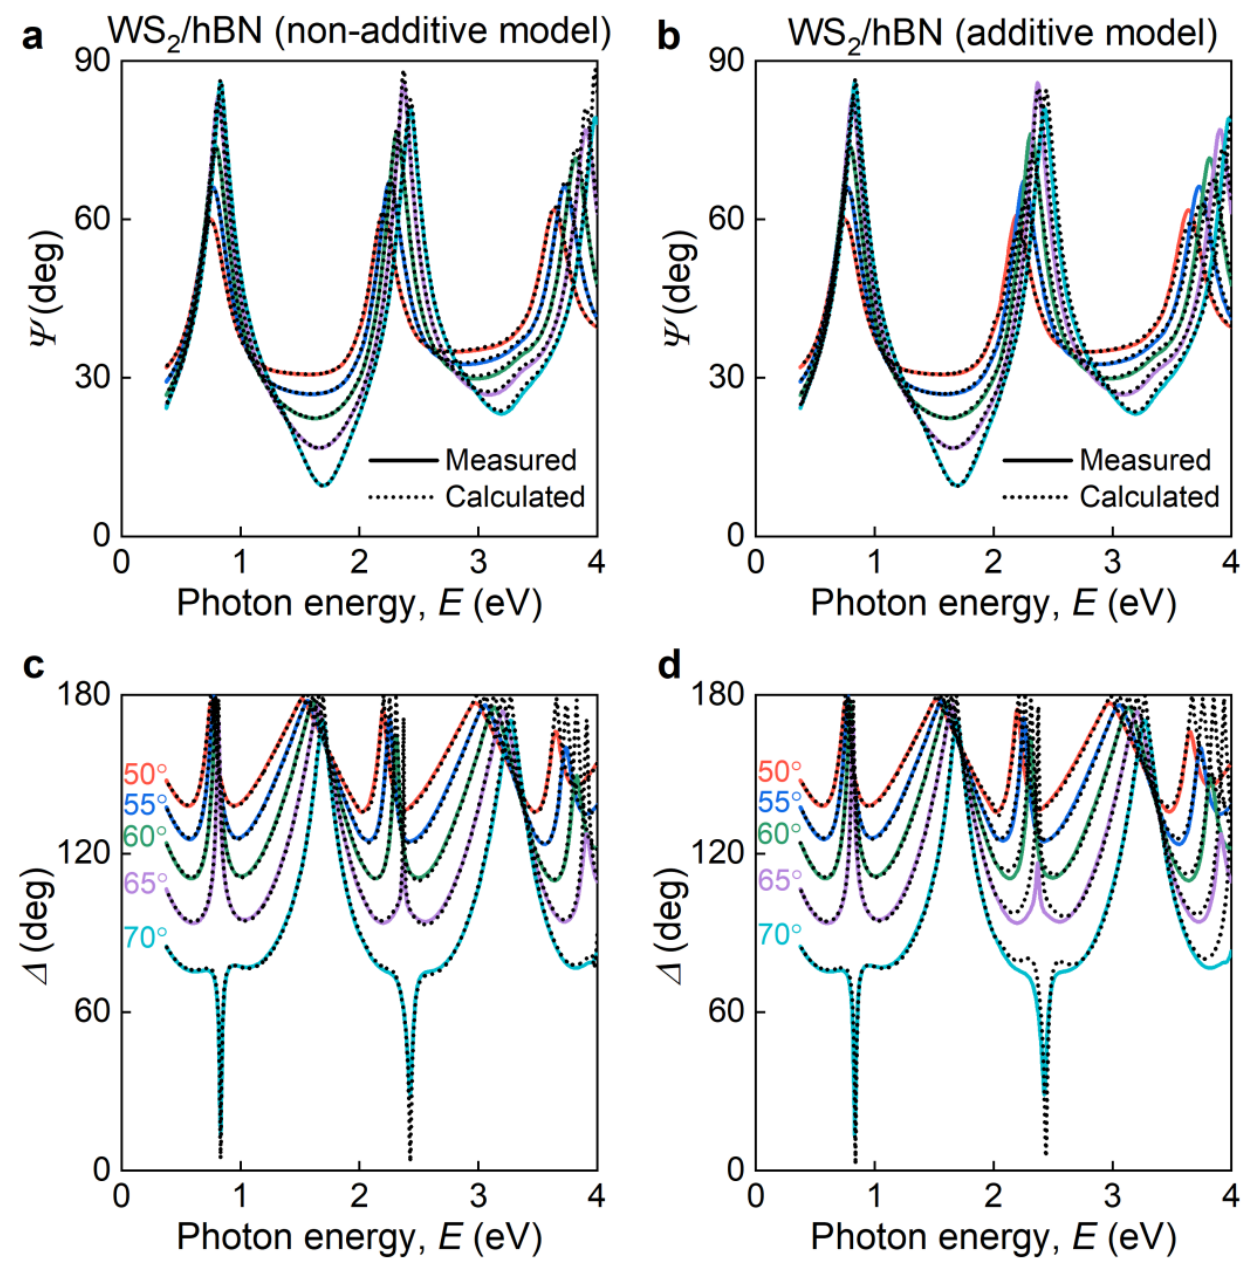
Figure A4. Ellipsometry spectra of WS 2 /hBN heterostructures. Comparison of non-additive and additive optical models for ( a , b ) Ψ and ( c , d ) ∆ . Red, blue, green, violet, and cyan lines correspond to 50 ◦ , 55 ◦ , 60 ◦ , 65 ◦ , and 70 ◦ incident angles, respectively.